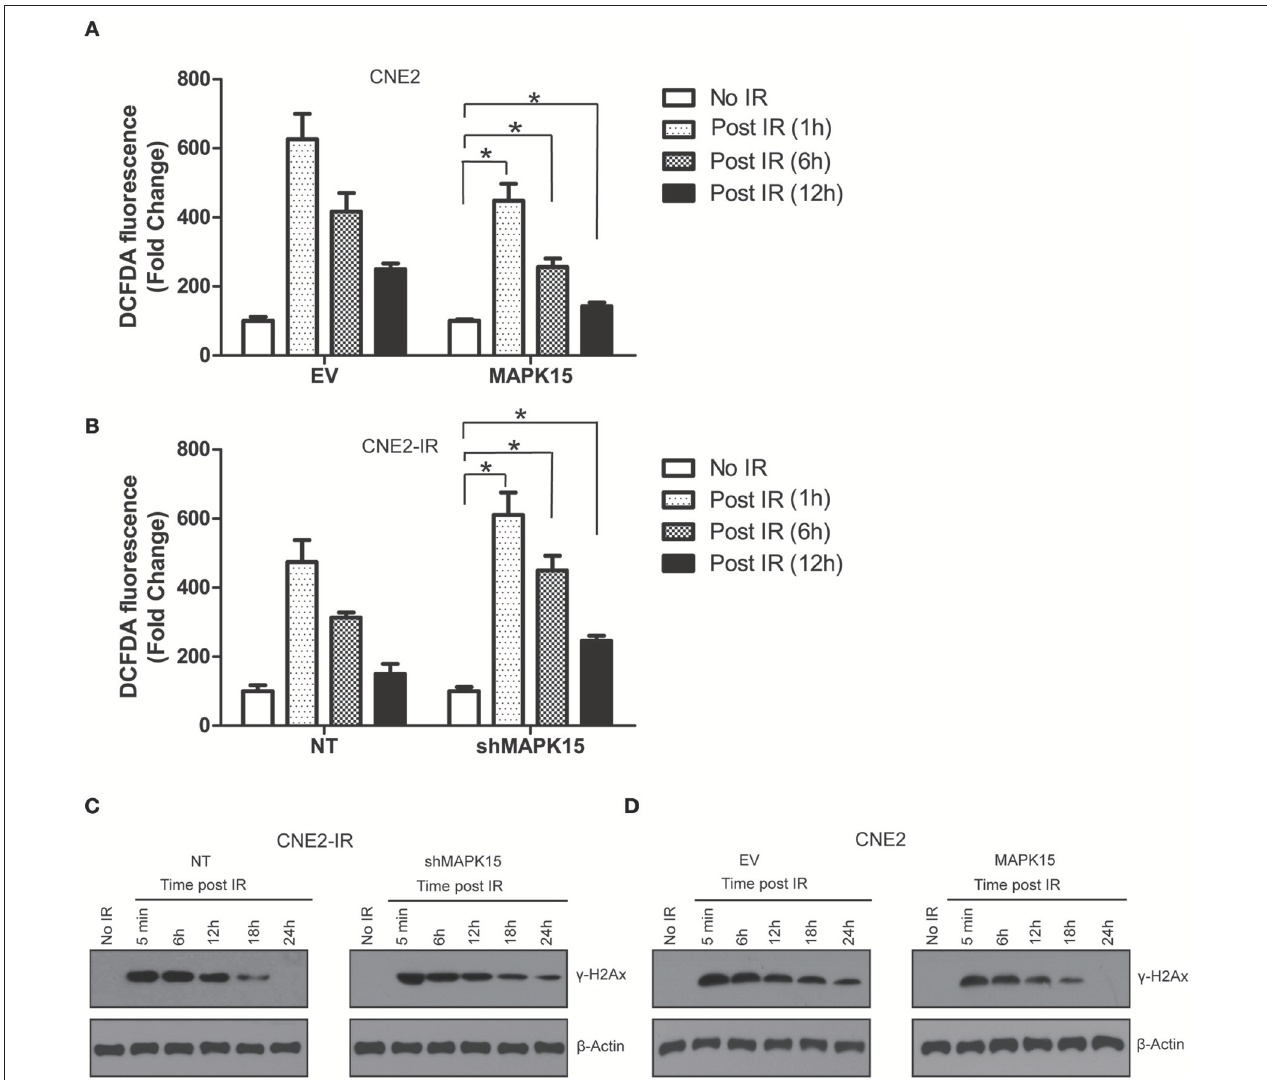
FIGURE 7 | MAPK15 regulates ROS accumulation and DNA damage repair in NPC cells. (A) Over-expression of MAPK15 enhanced the neutralization of ROS accumulation in CNE2 cells exposed to irradiation. The DCFDA fluorescence in EV or MAPK15 without ionizing irradiation was regarded as 100%. MAPK15 (1h, 6h, 12h) vs. EV (1h, 6h, 12h), n = 4, * P < 0.05, respectively. (B) Knockdown of MAPK15 delayed the attenuation of ROS in CNE2-IR cells exposed to irradiation. The DCFDA fluorescence in NT or shMAPK15 without ionizing irradiation was regarded as 100%. shMAPK15 (1h, 6h, 12h) vs. NT (1h, 6h, 12h), n = 4, * P < 0.05, respectively. (C) Knockdown of MAPK15 delayed the DNA damage repair in CNE2-IR cells exposed to irradiation. γ -H2AX was used as a marker to reflect the double strand DNA breaks (DSBs) that are produced by ionizing radiation. β -actin served as a loading control. (D) Over-expression of MAPK15 in CNE2 cells promoted the DNA damage repair in CNE2-IR cells exposed to